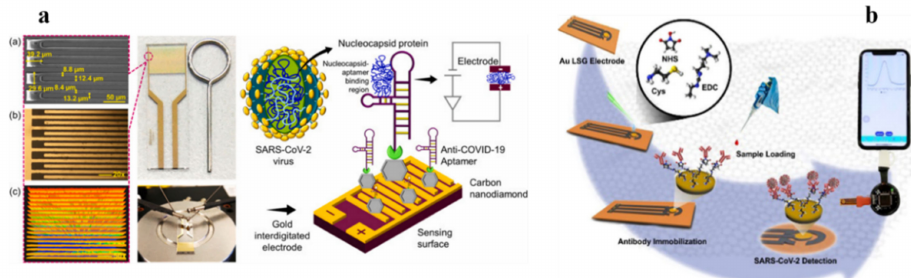
Figure 2. Schematic illustration of electrochemical biosensors fabricated with carbon nanomaterials for detection of SARS-CoV-2: ( a ) biosensor based on anti-NCP aptamer on diamond enhanced gold interdigitated electrode (AuIDE) for detecting NCP of SARS-CoV-2 [62]; ( b ) biosensor based on gold-nanoarchitecture-assisted laser-scribed graphene for detecting SARS-CoV-2 at the point-of- care [46]. Note: ( a ) is reproduced with permission Copyright 2021, Elsevier B.V.; ( b ) is reproduced with permission Copyright 2021, American Chemical Society.